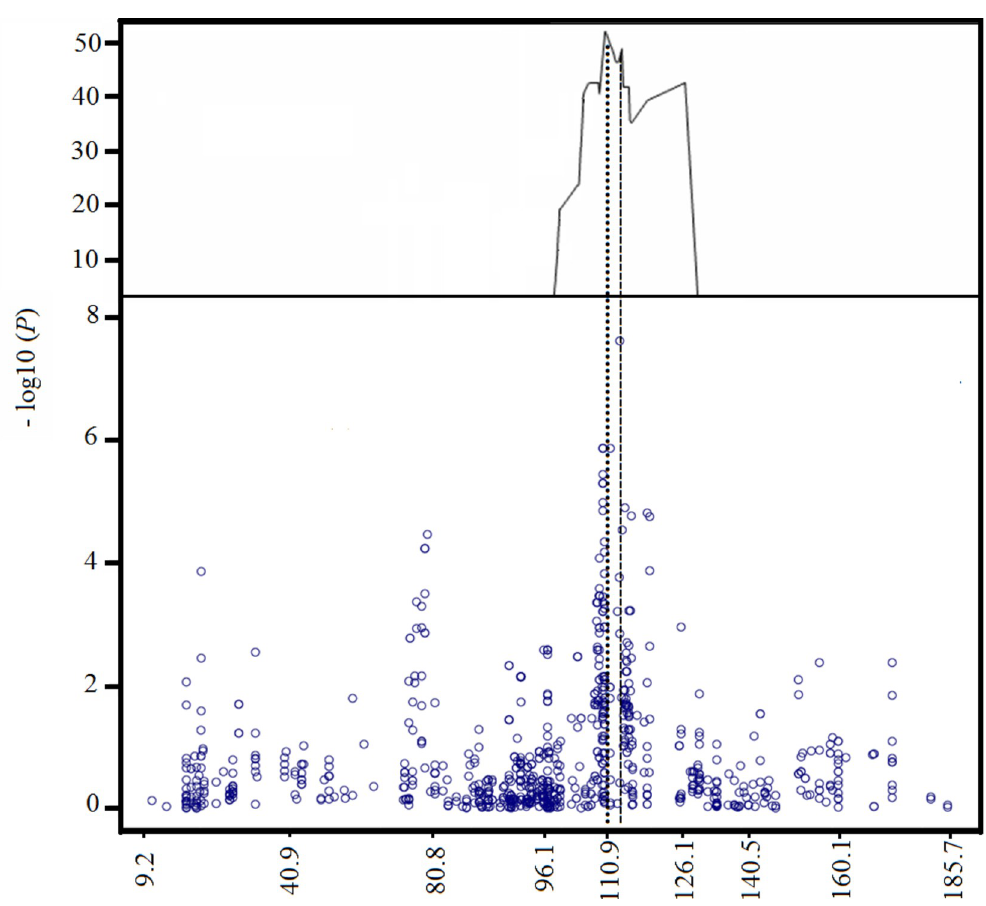
Fig 2. Genetic mapping of the Yr7 locus. The uppermost plot shows the CIM QTL scan of chromosome 2B for resistance to yellow rust isolate Pst 08/21 in the AxC DH population. The lower plot shows the GWAS Manhattan plot of chromosome 2B (showing only 353 markers in common with AxC), using AxC map order and distances (cM) to scale the X-axis.